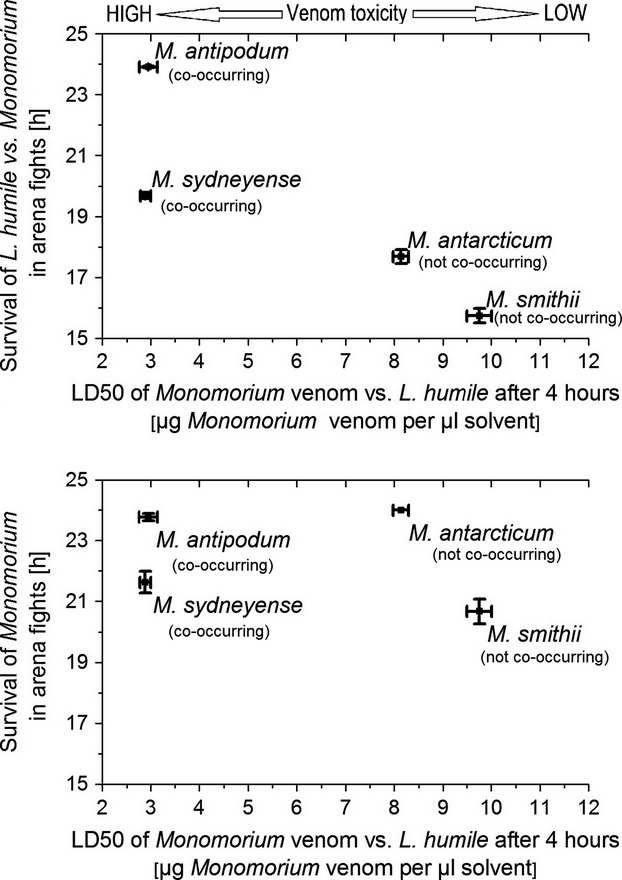
Monomorium toxicity and ant survival. Overall survival time of Argentine ant workers in arena fights against four Monomorium species correlated with the LD50 of the venom of that Monomorium species (top) and the overall survival time of Monomorium workers in arena fights against Argentine ants correlated with the LD50 of the venom of that Monomorium species (bottom).